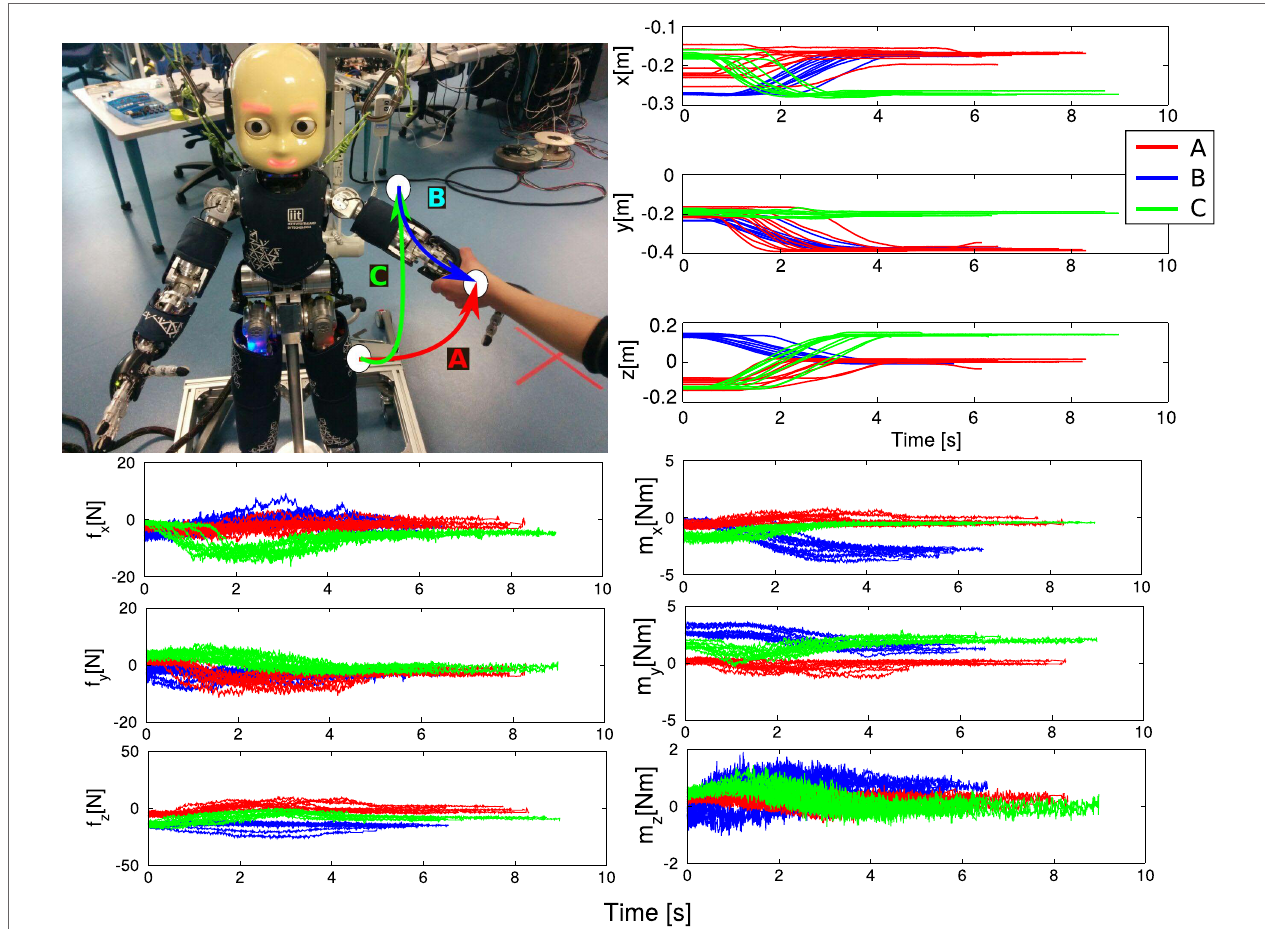
FIGURE 10 | Top left: the iCub and the visualization of the three targets in its workspace, defining the three tasks A–B–C. Top right: Cartesian position information of the demonstrated trajectories for the three tasks. Bottom left and right: wrench (force and moment) information of the demonstrated trajectories.